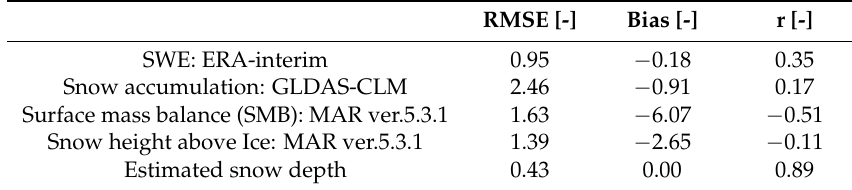
Table 6. Root mean square error (RMSE), bias, and correlation coefficient (r) for the standardized anomaly (SA) of each product; here mean depth is used as the in situ snow depth. RMSE [-] Bias [-] r [-] SWE: ERA-interim 0.95 − 0.18 0.35 Snow accumulation: GLDAS-CLM 2.46 − 0.91 0.17 Surface mass balance (SMB): MAR ver.5.3.1 1.63 − 6.07 − 0.51 Snow height above Ice: MAR ver.5.3.1 1.39 − 2.65 − 0.11 Estimated snow depth 0.43 0.00